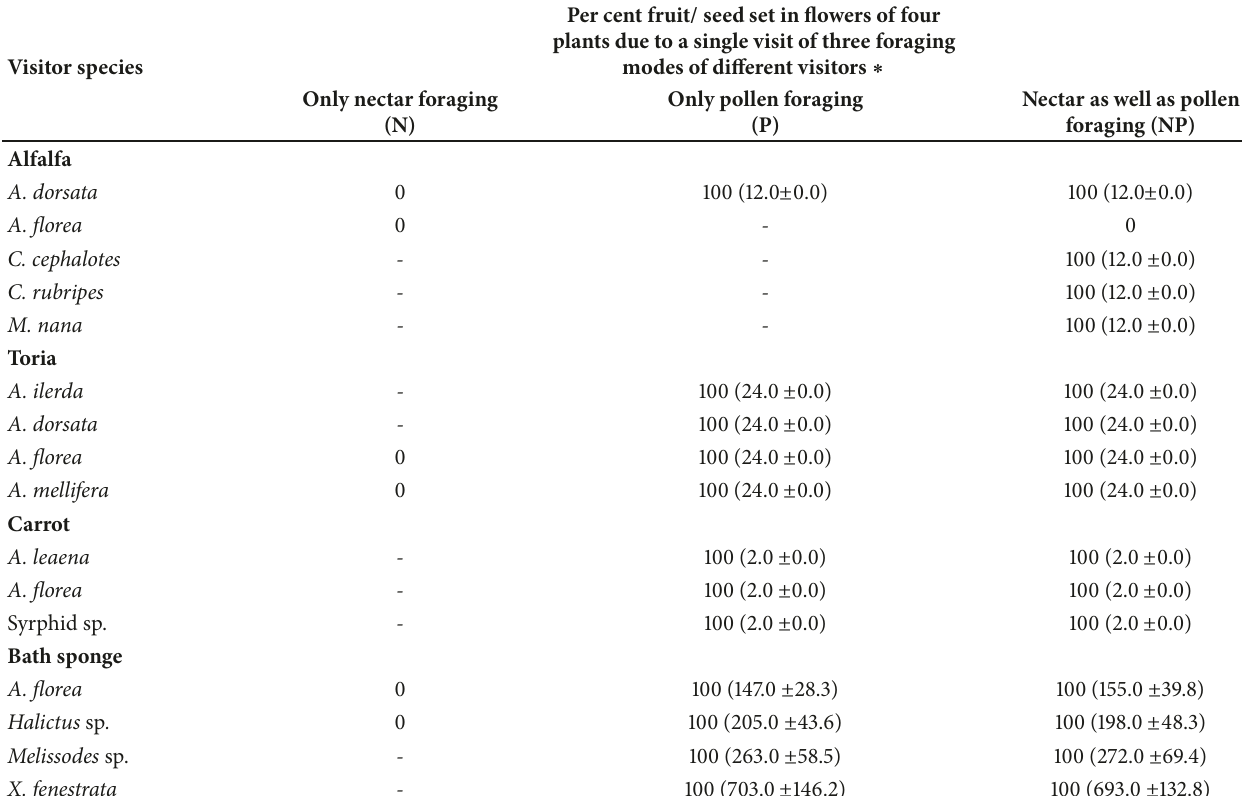
Table 3: Fruit/seed set in flowers of four plant species resulting from a single visit of three foraging modes of different visitors.